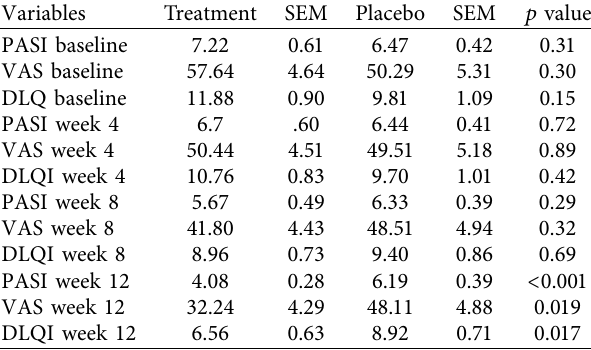
Table 1: Comparison of demographic data in both groups. Variables